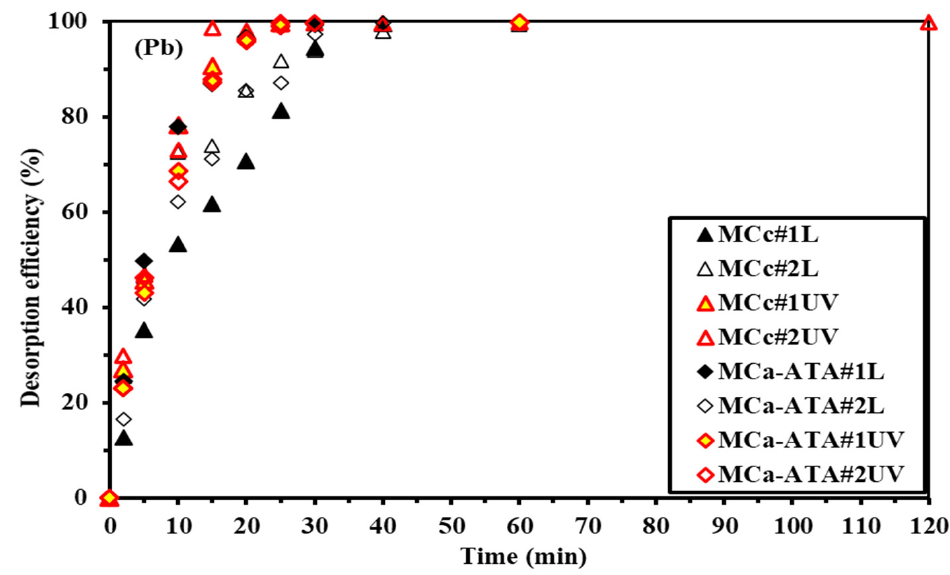
Figure 9. Desorption kinetics of the MCc and MCa-ATA from 0.2 M HCl solution under visible light (L) and UV. Table 5. Sorption desorption cycles of MCc and MCa-ATA for five cycles using 0.2 M HCl solution. MCc MCa-ATA SORPTION DESORPTION